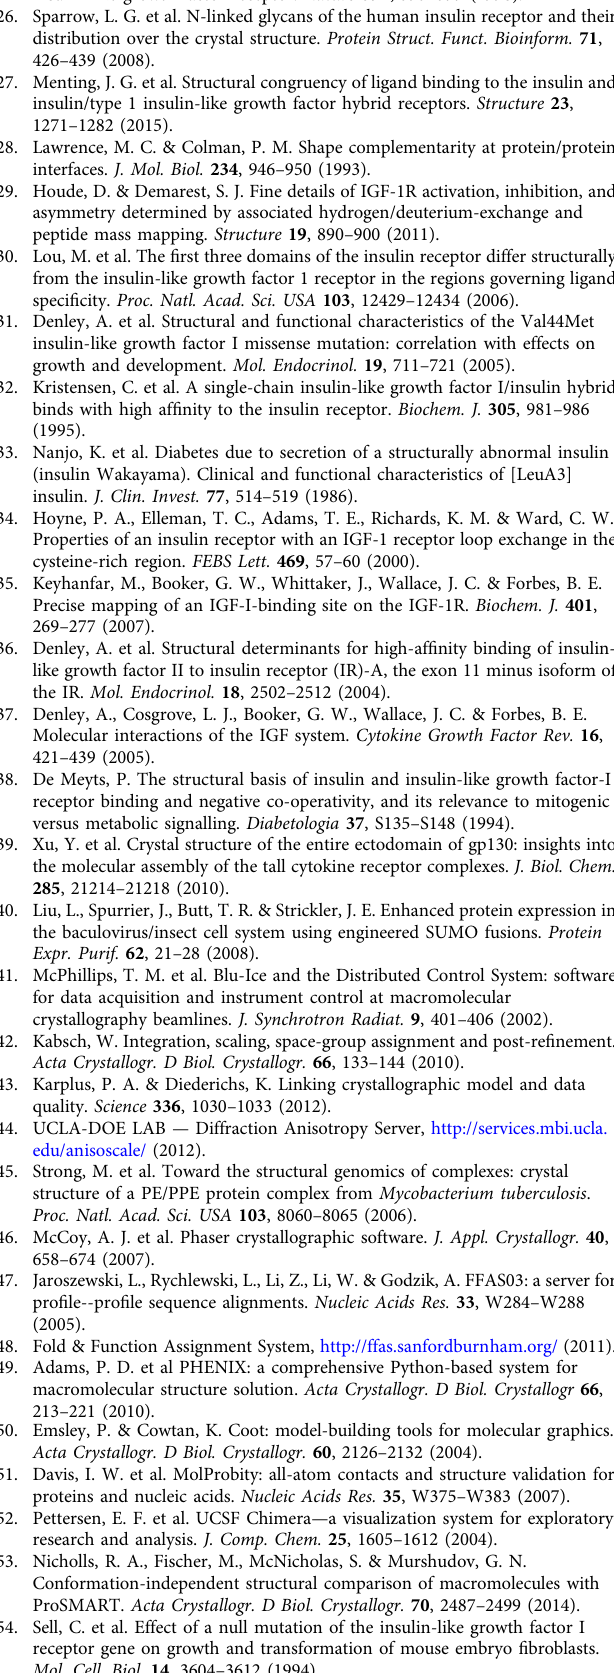
Supplementary Table 5. No attempt was made to obtain a best fi t of parameters or to establish if the identi fi ed parameter set is unique; nevertheless, the identi fi ed set of parameters leads to good agreement with experimental data (Fig.